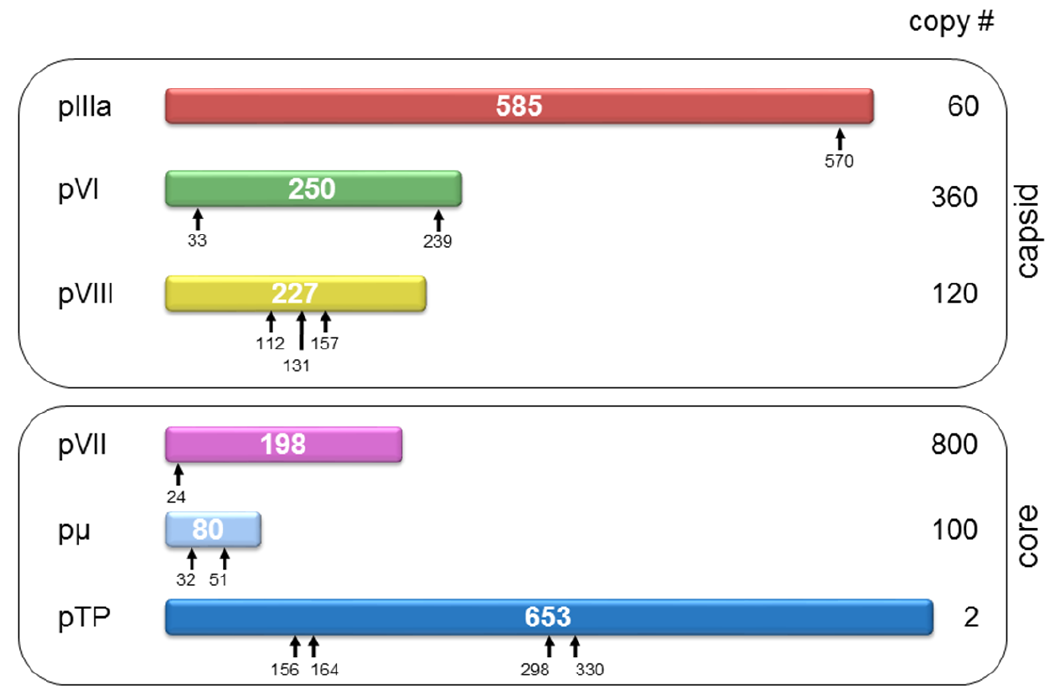
Figure 7. Virion components undergoing proteolytic maturation. Each HAdV-5 precursor protein is represented as a bar with the polypeptide length in amino acids indicated in the center. Cleavage sites are denoted by arrows. There are four potential cleavage sites in pTP but they have not been experimentally verified. The prefix “p” denotes the unprocessed